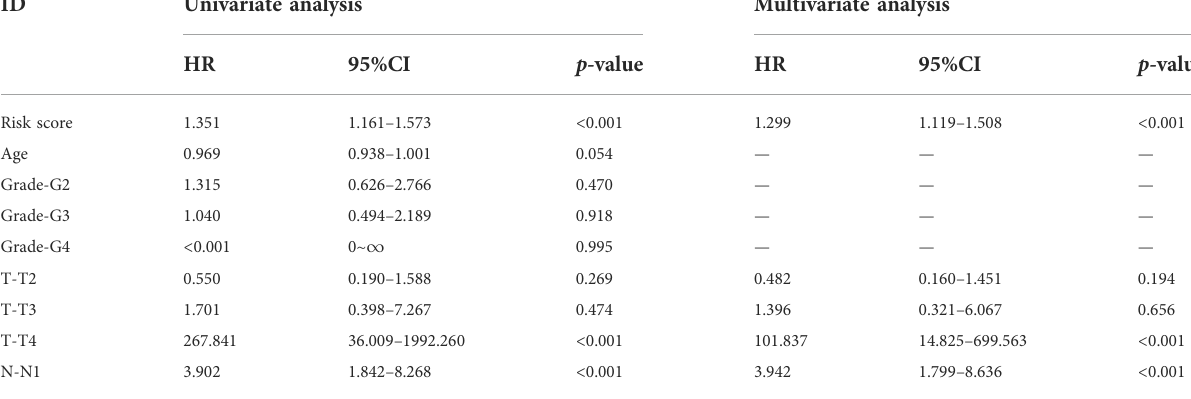
TABLE 2 Univariate and multivariate Cox regression analysis of clinical factors and risk score with